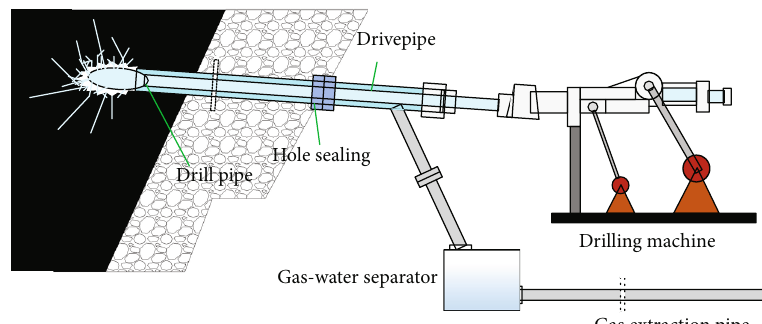
Figure 8: Schematic diagram of underground hydraulic punching [45].